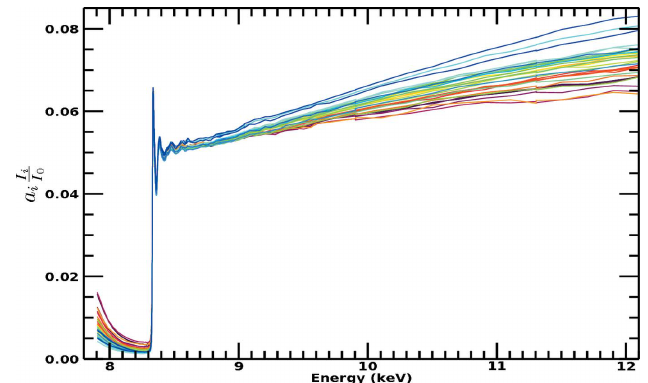
Figure 4 Fluorescence spectra for the nickel i -pr complex extended to higher energy. The increasing dispersion with energy is particularly evident across the larger energy range. Detector efficiency normalization is not sufficient to remove the large self-absorption signature and systematic from the spectra. An overall scale factor a i is intrinsic to the fluorescence data because of the pixel efficiency, as discussed in the text. The colour scheme is consistent with previous